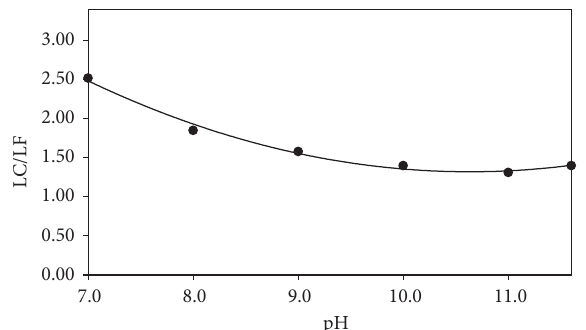
Figure 1: A plot of LC/LF ratio versus pH on complete disappear- ance of RF.